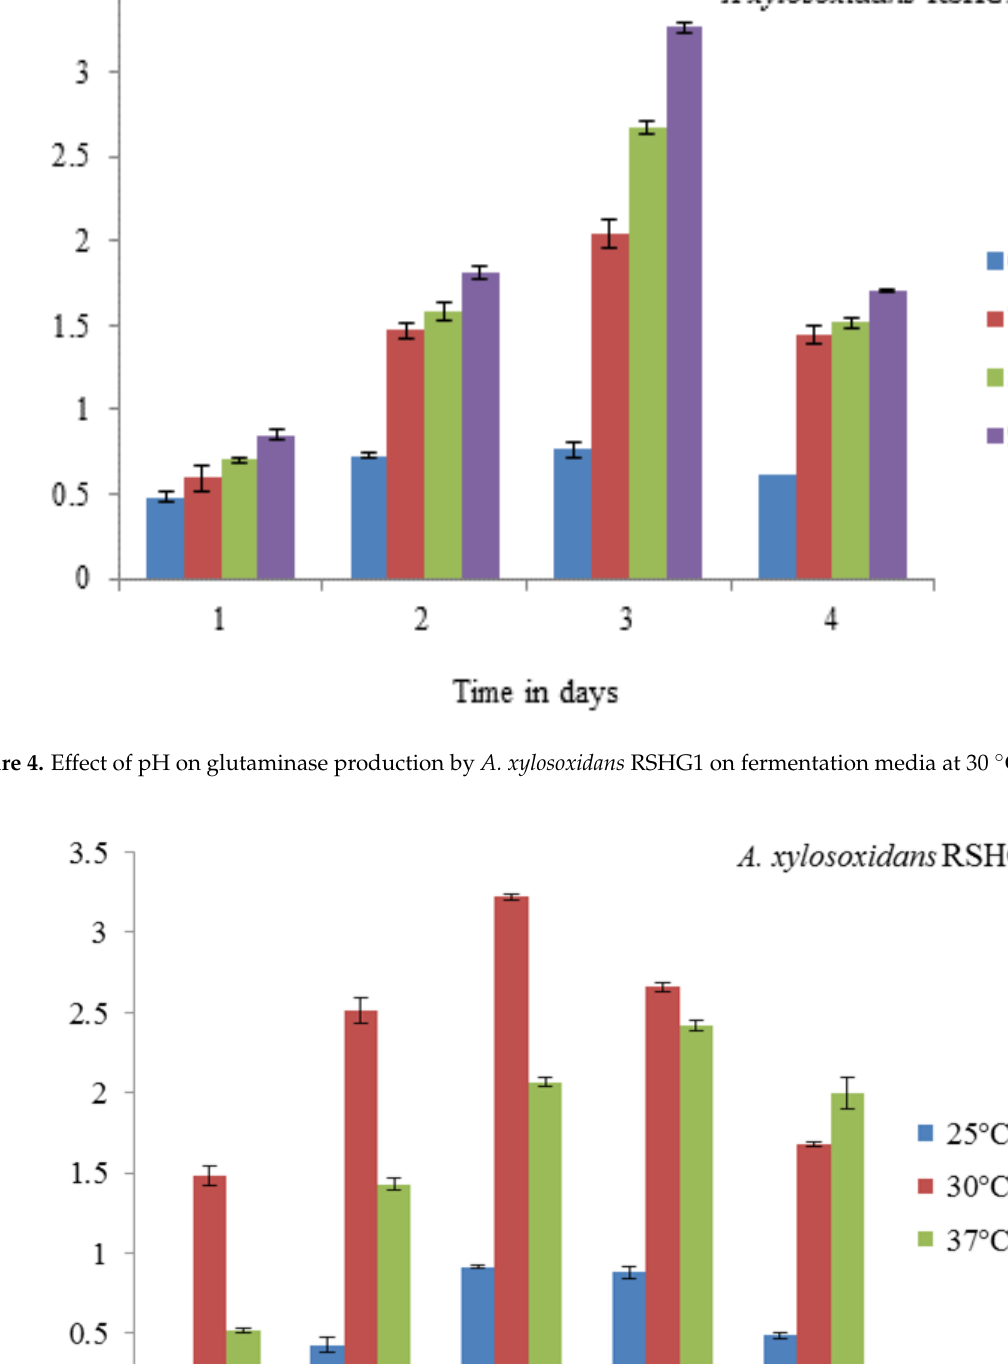
Figure 3. Production of glutaminase by A. xylosoxidans RSHG1 bacteria in fermentation media at 37 °C, pH 6.8.